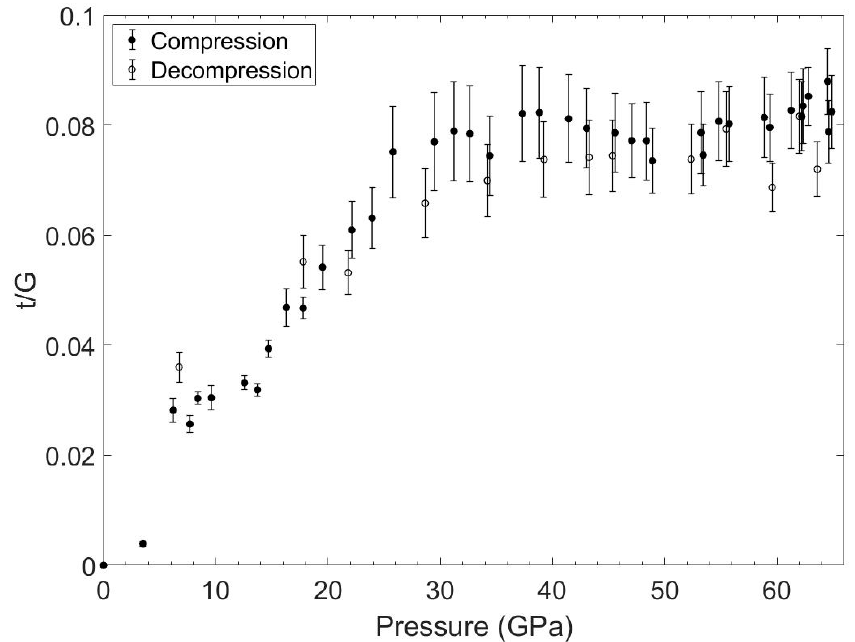
Figure 10. The measured value of differential stress (t) normalized to shear modulus for HEB (Hf, Mo, Nb, Ta, Ti)B 2 sample to 65 GPa. The data are shown for both compression and decompression cycles. The HEB sample shows high differential stress, approaching 8% of the shear modulus.